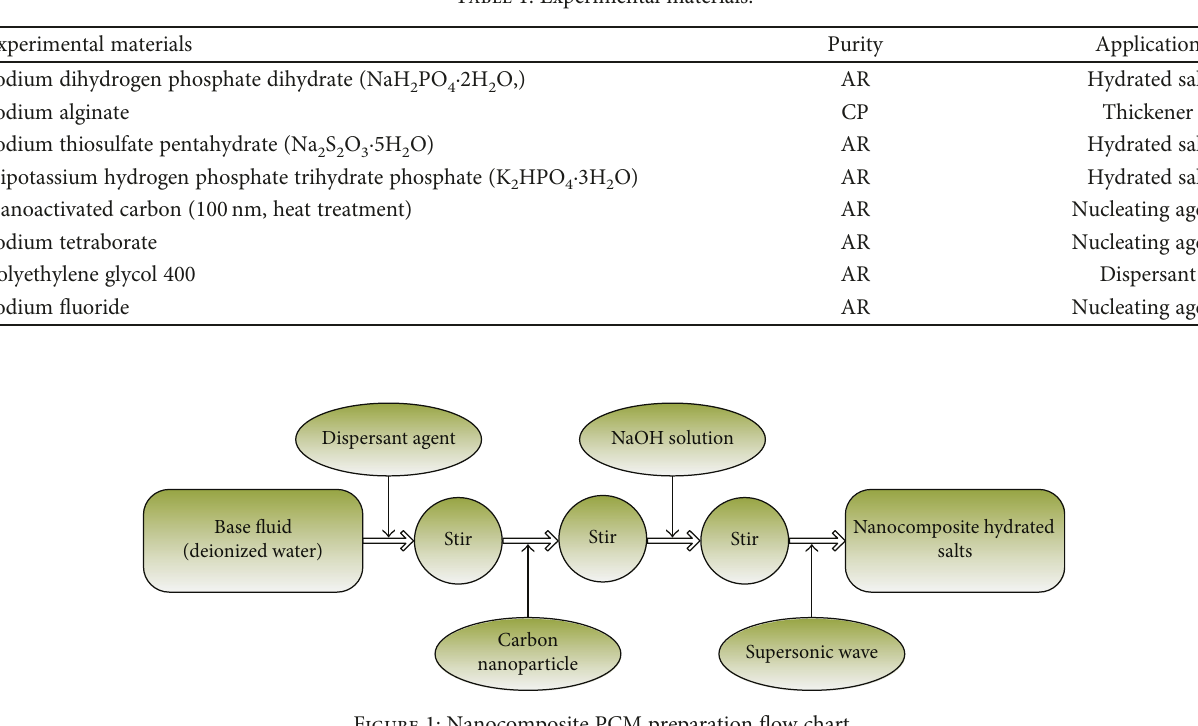
Table 1: Experimental materials.